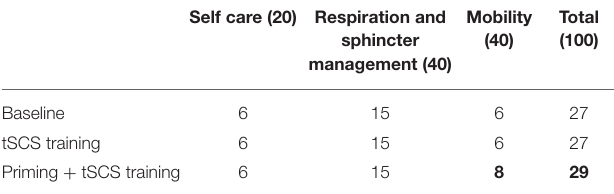
TABLE 3 | Spinal cord independence measure